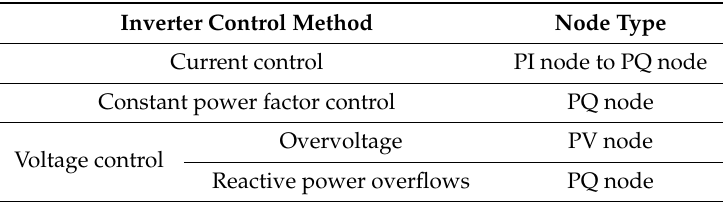
Table 1. The type of nodes of PV power